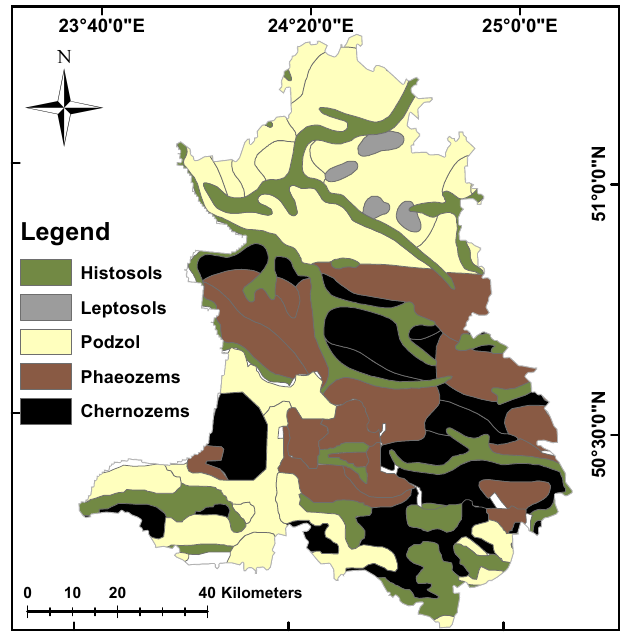
Figure 4. Map showing the distribution of soil in our study